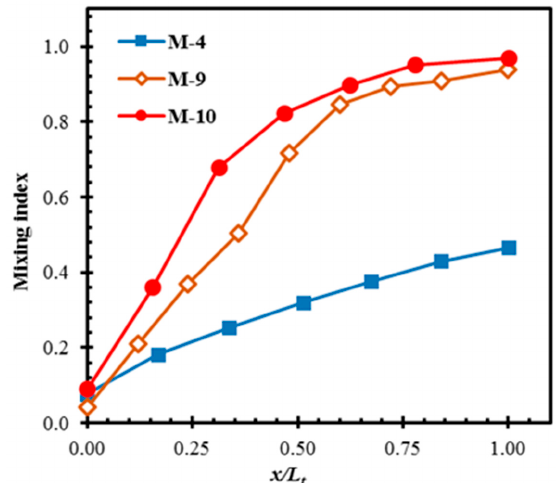
Figure 12. Developments of mixing along the length of the micromixers at Re = 0.01.